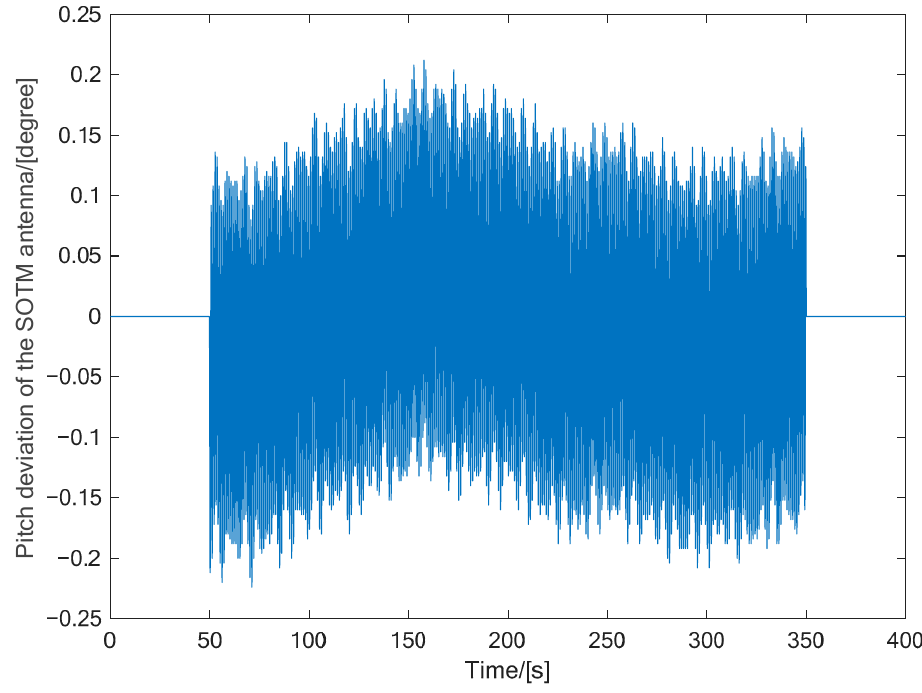
Figure 10. Converted pitch deviation.